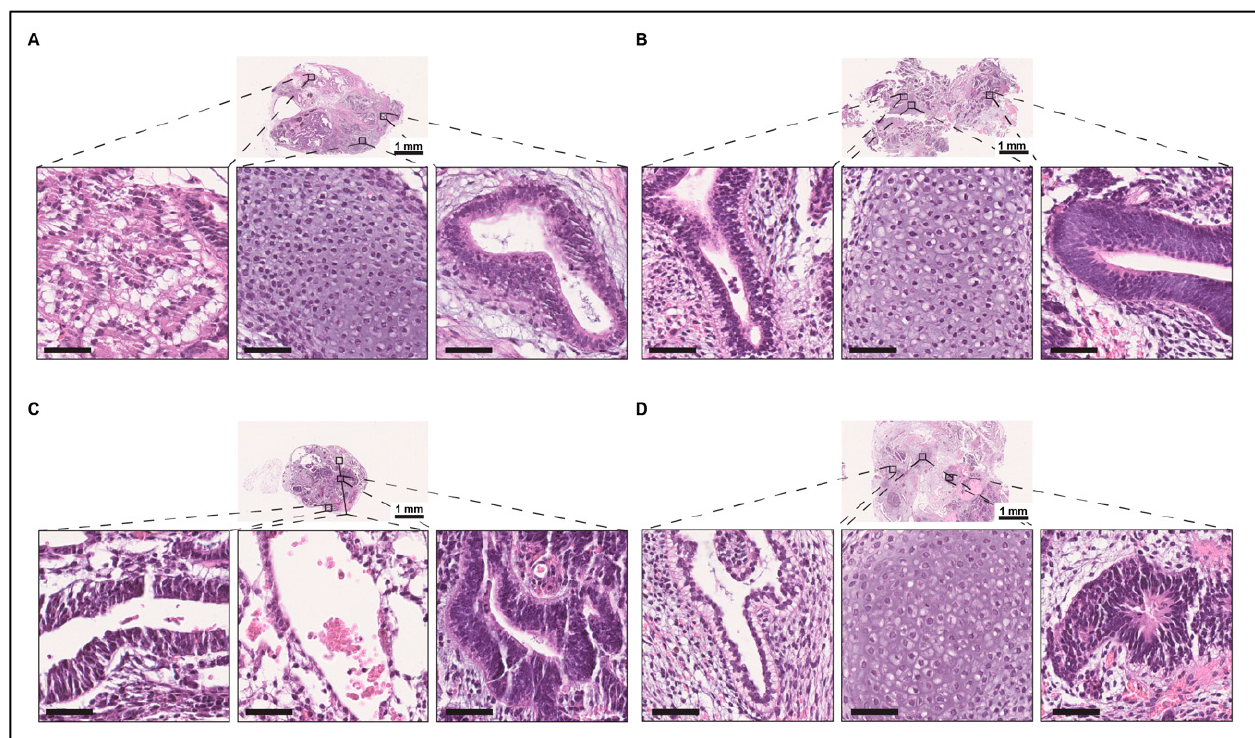
Figure 7. Teratoma formation assay of MS-hiPSCs, WT-hiPSC-M, and WT-hiPSC-F. ( A ): Teratoma formed by MS-hiPSCs with evidence of endodermal tubules, cartilage, and neural tubes (left to right). ( B ): Teratoma formed by WT-hiPSC-M with evidence of endodermal tubules with subnuclear vacuolization, cartilage, and neural tubes (left to right). ( C ): Teratoma formed by WT-hiPSC-F with evidence of endodermal tubules, blood vessels, and neural tubes (left to right). ( D ): Teratoma formed by the positive control NKL5 with subnuclear vacuolization, cartilage, and neural tubes (left to right). ( A – D ): Examples of endodermal, mesodermal, and ectodermal derivatives as proof of pluripotency (scale bar = 50 μ m unless otherwise indicated).